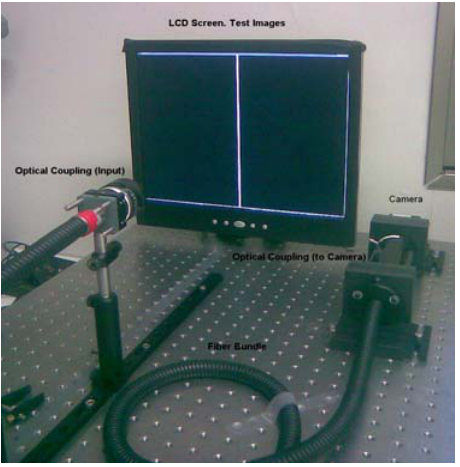
Figure 1. System